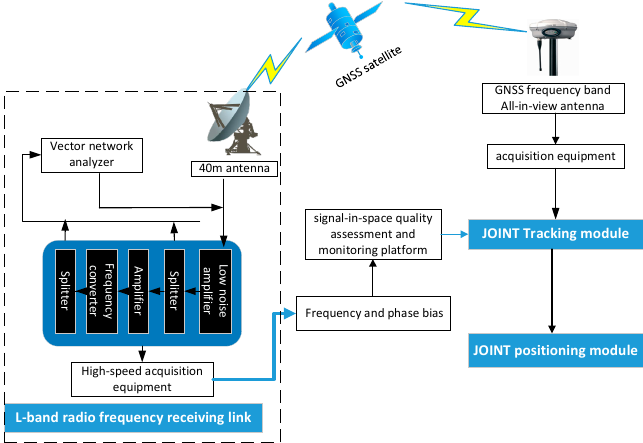
Figure 9. Architecture of the test platform.